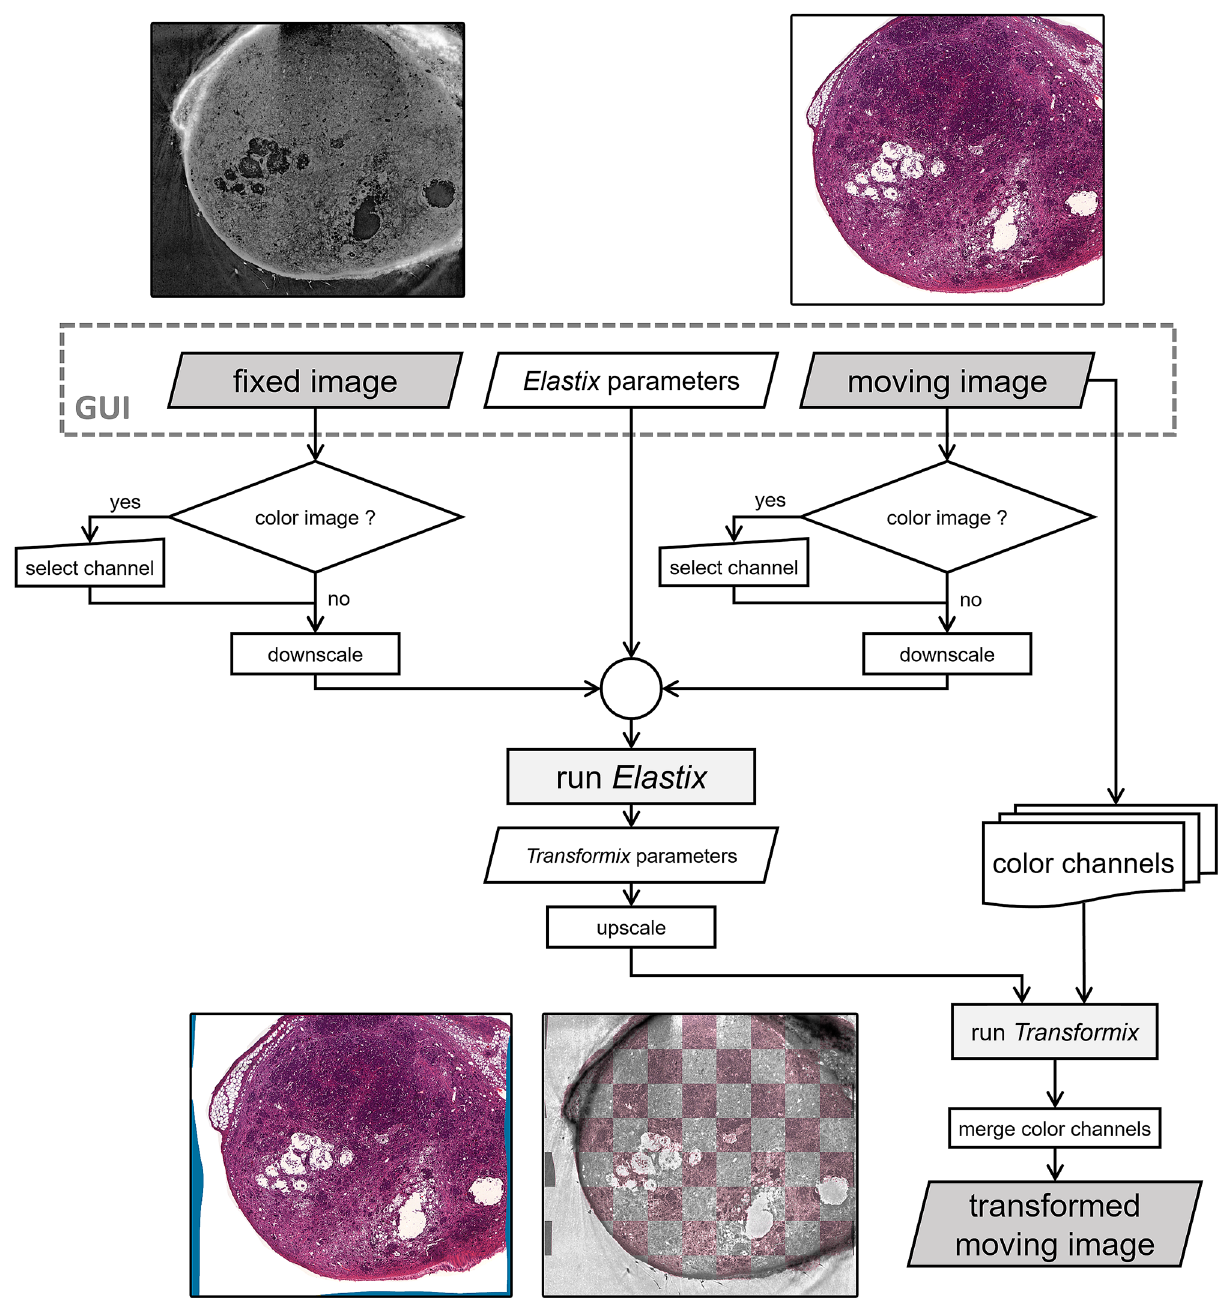
Figure 1. Image transformation pipeline using the Fuxlastix frontend. The fixed image (non-transformed CT image, top left), the moving image (histology image to be transformed, top right) and the Elastix parameter file are chosen manually in the user interface (GUI) of the software. If colour images are selected, the user needs to decide manually which colour channel should be used for the matching process. In addition, there is a choice to select the average of the colour channels as a grey value image and/or to invert the image. The images are downscaled by a factor of 10 and the Elastix software is called, which outputs the Transformix parameter file, which in turn is modified for the use on the original moving image. Each channel is transformed individually and subsequently merged to receive the final transformed moving image (bottom row, left image). The overlay of the fixed and the transformed overlay can be visualised using a checkerboard pattern (bottom row, right